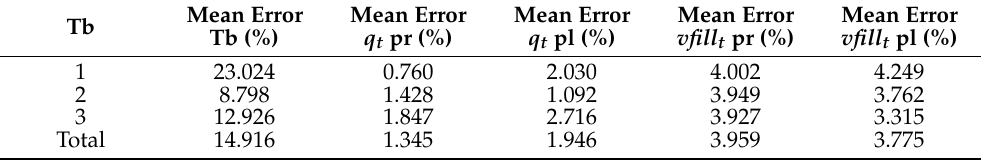
Table 7. Mean error in the results of the braking type, q t and vfill t simulations of the pressure sensors. Tb